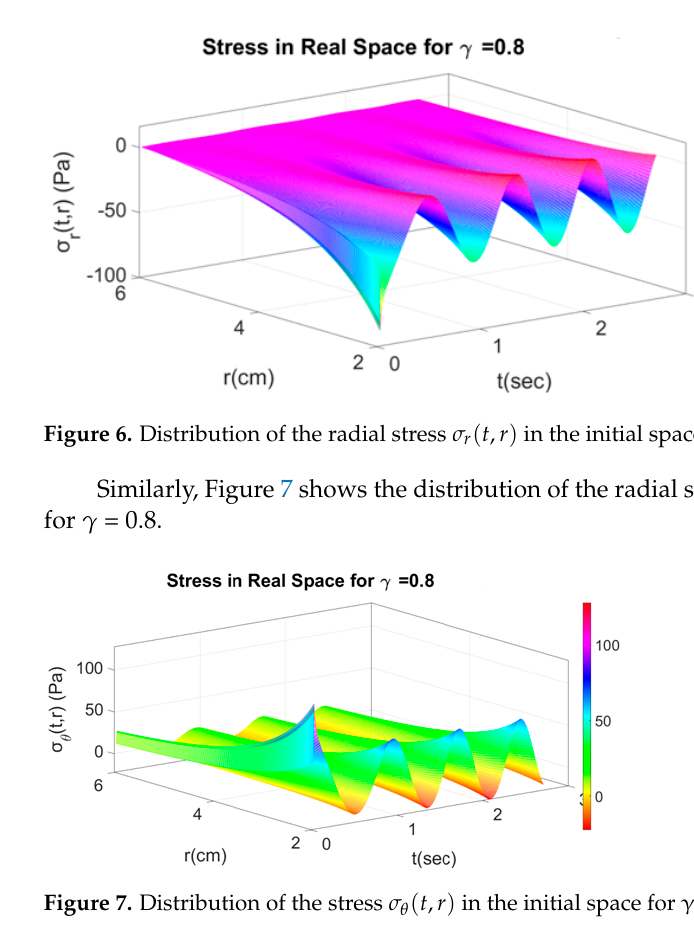
Figure 5. Distribution of the stress σ θ ( t , r ) in the initial space for γ = 0.9. In addition, Figure 6 shows the distribution of the radial stress σ r ( t , r ) in the initial space for γ = 0.8.